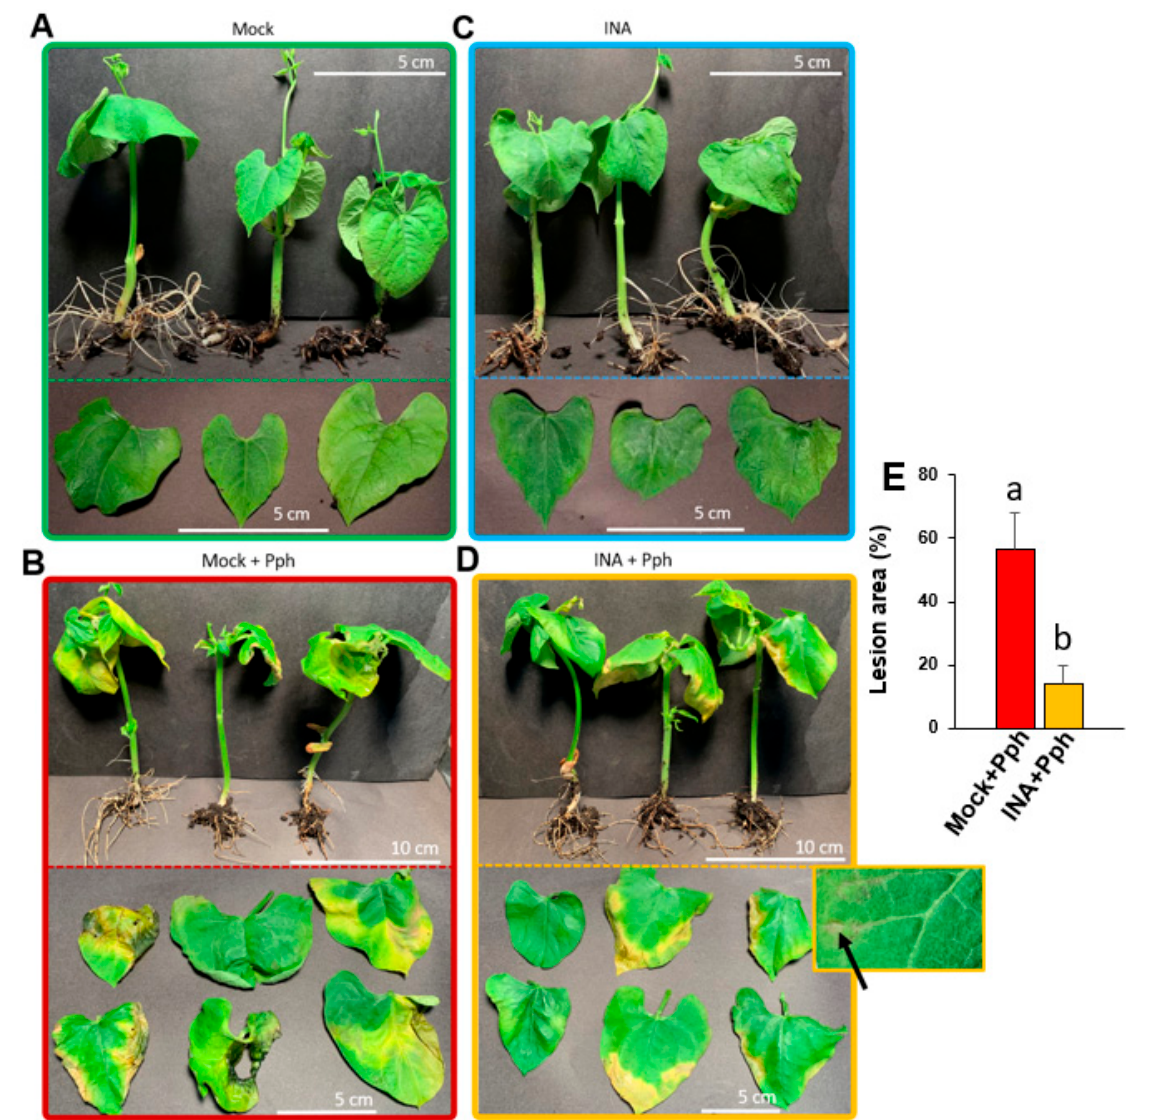
Figure 1. Phenotypic damage caused by the virulent bacteria P. syringae pv. phaseolicola (Pph) in common bean plants. Entire plants and extended leaves are shown to compare symptoms in Mock ( A , C ) and INA-pre-treated plants ( B , D ), non- ( A , B ) or Pph-inoculated ( C , D ). In panel D, a detail of the observed necrotic spots indicative of hypersensitive response (pointed by an arrow) is shown. ( E ) Quantification of the lesion area. Data represent mean ± SE ( n = 6) and statistically differences, indicated by letters, were achieved according to t -Student test ( p < 0.05). Pictures correspond to one experiment representative of three independent ones with similar results.